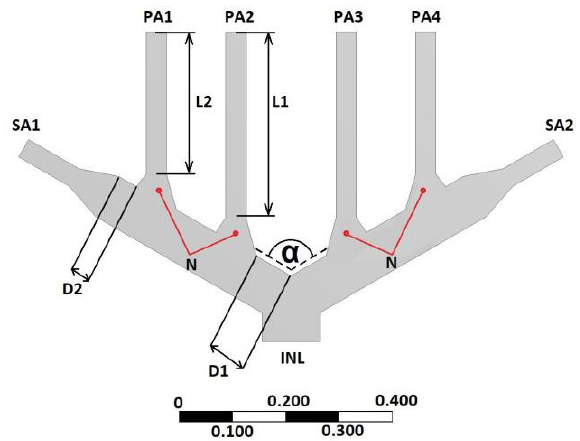
Fig. 3. The proposed shape (cross section of the symmetry plane) of the newly designed air manifold with specified input